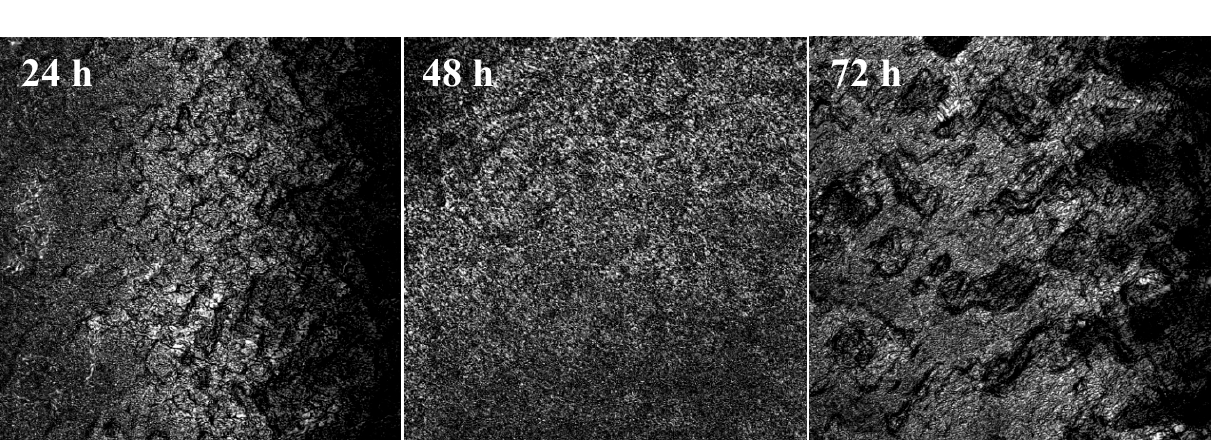
Figure 7. CLSM images of K. pneumonia biofilm developed on Fe 3 O 4 @C 14 -VAN coated substrata at 24 h, 48 h and 72 h; bacteria occur as punctiform, round cells distributed on the coated